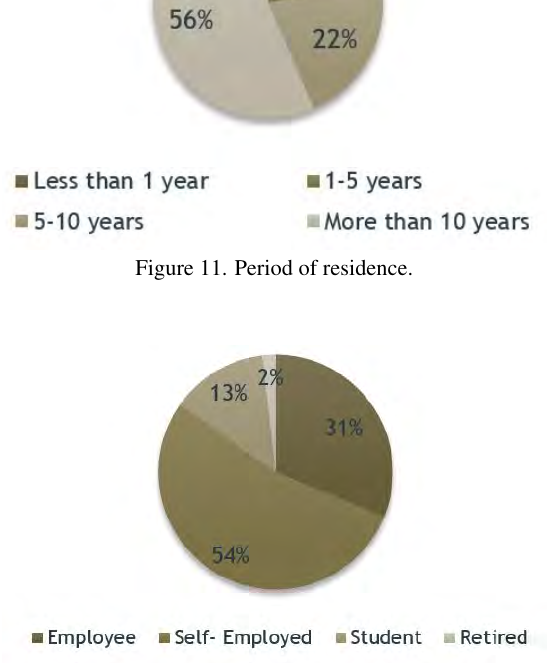
Figure 12. Occupational